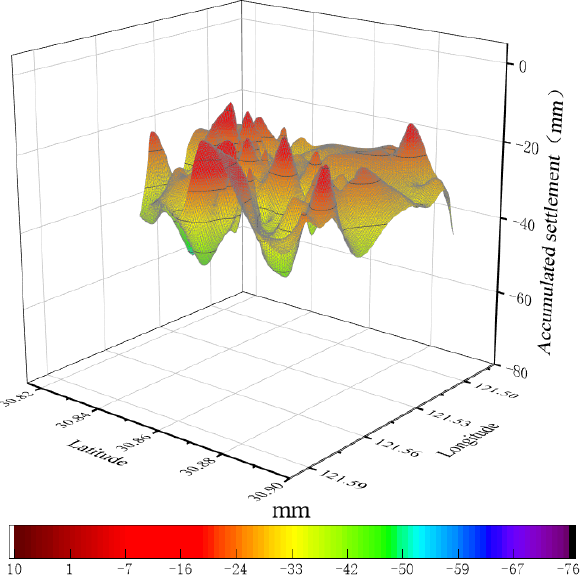
Figure 14. 3D accumulative subsidence map of characteristic area.